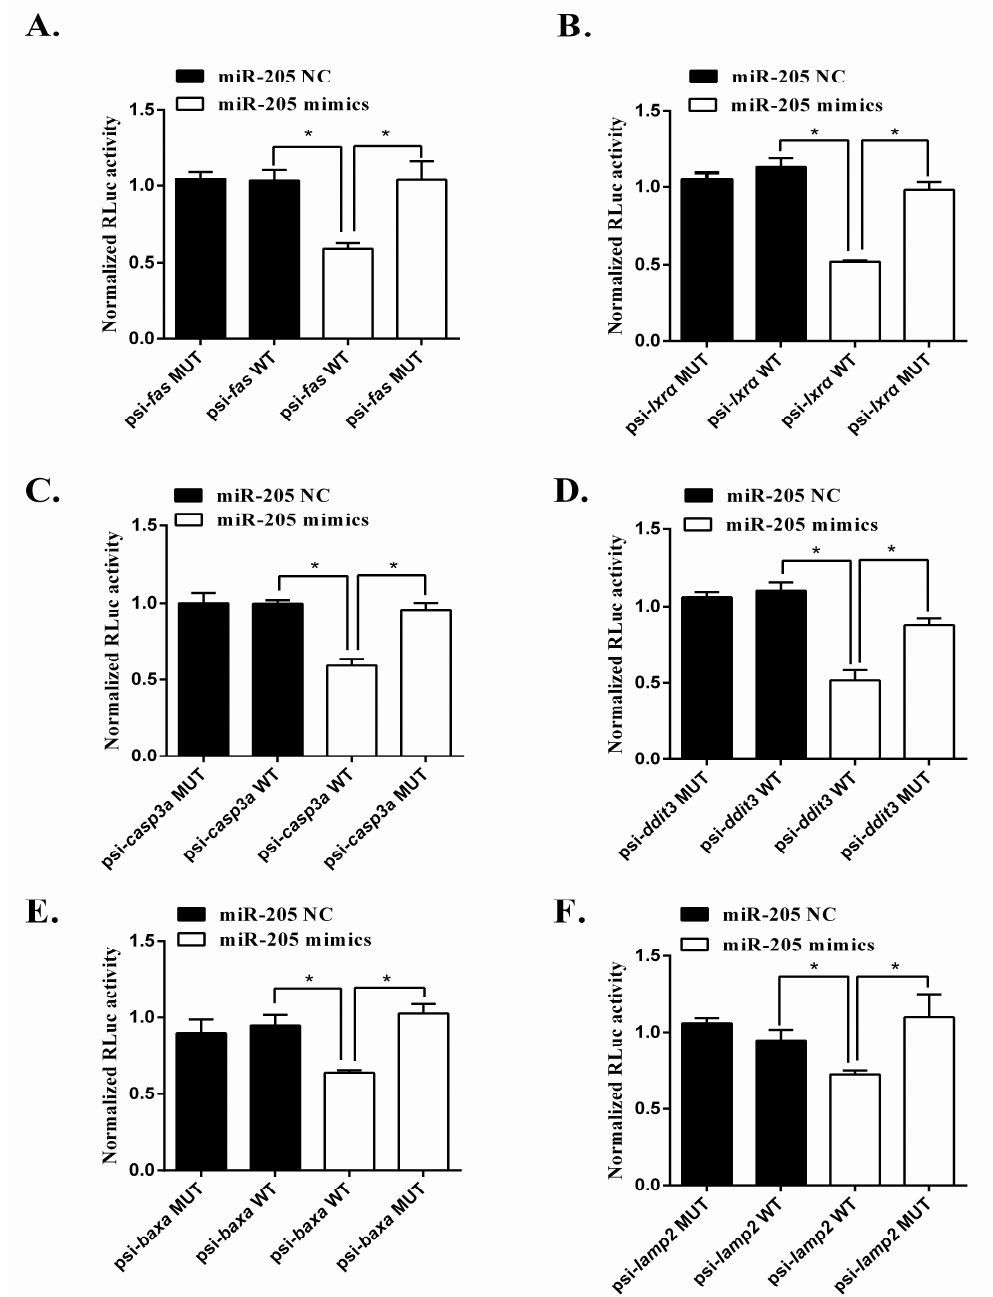
Figure 6. Activities of the luciferase reporter gene linked to the 3 ′ UTR of fas ( A ), lxr α ( B ), casp3a ( C ), ddit3 ( D ), baxa ( E ) and lamp2 ( F ). The psiCHECK2 luciferase reporter plasmids with the wild-type or mutated 3 ′ UTR sequences of fas , lxr α , ddit3 , casp3a , baxa and lamp2 were transiently transfected into HEK-29T cells along with 20 μ M miR-205 mimics or negative control. Luciferase activities were measured after 24 h, and firefly luciferase was used for normalization. Mean of the results from the cells transfected by psiCHECK2 vector was set as 1. The data are the mean and standard deviation (SD) of separate transfections ( n = 3). * p < 0.05; NS; Student’s t test. The experiment was repeated at least three times.